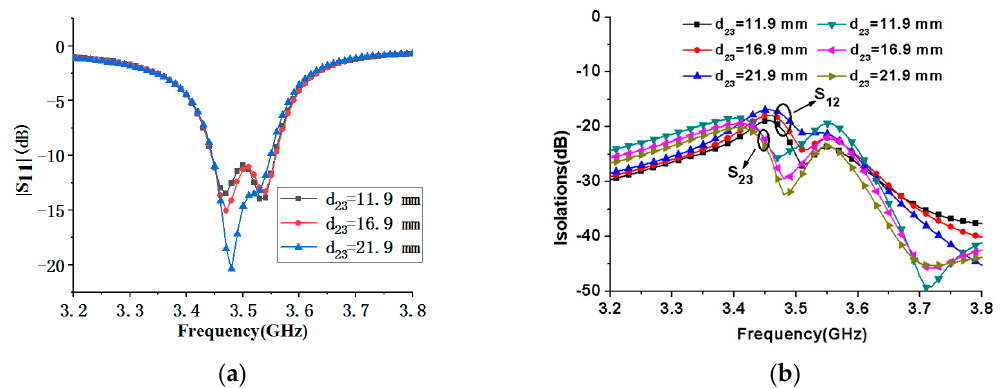
Figure 17. Comparison of |S 11 | and isolation of the proposed antenna with different antenna element spacing d 23 : ( a ) |S 11 | comparison; ( b ) |S 21 |and |S 23 | comparison.